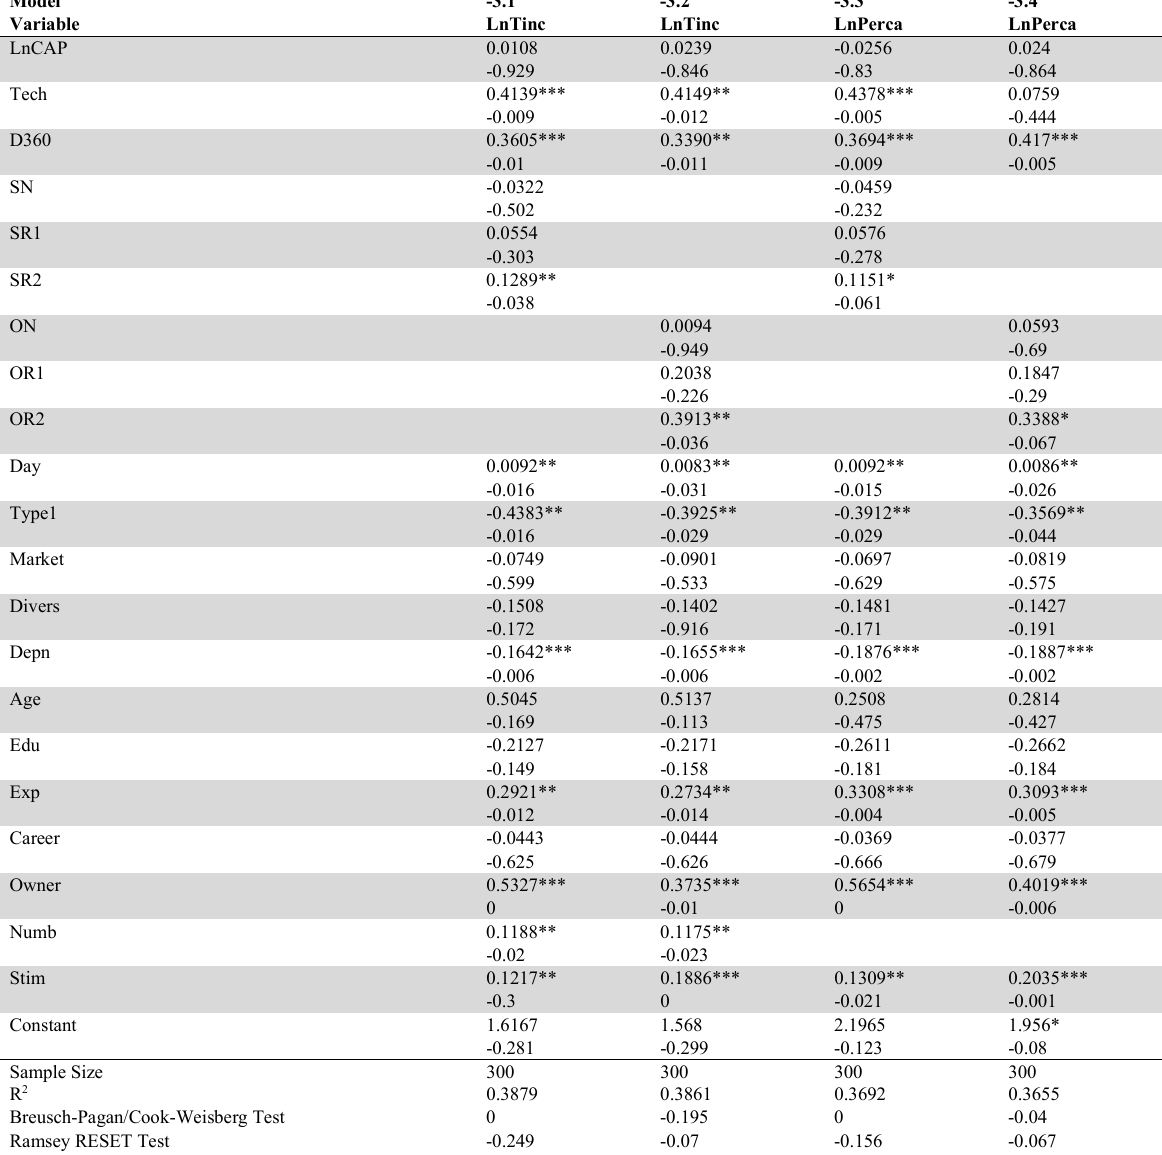
Factors Affecting Offshore Income of Fishing Households in the South Central Coast : Model with Slope Dummies